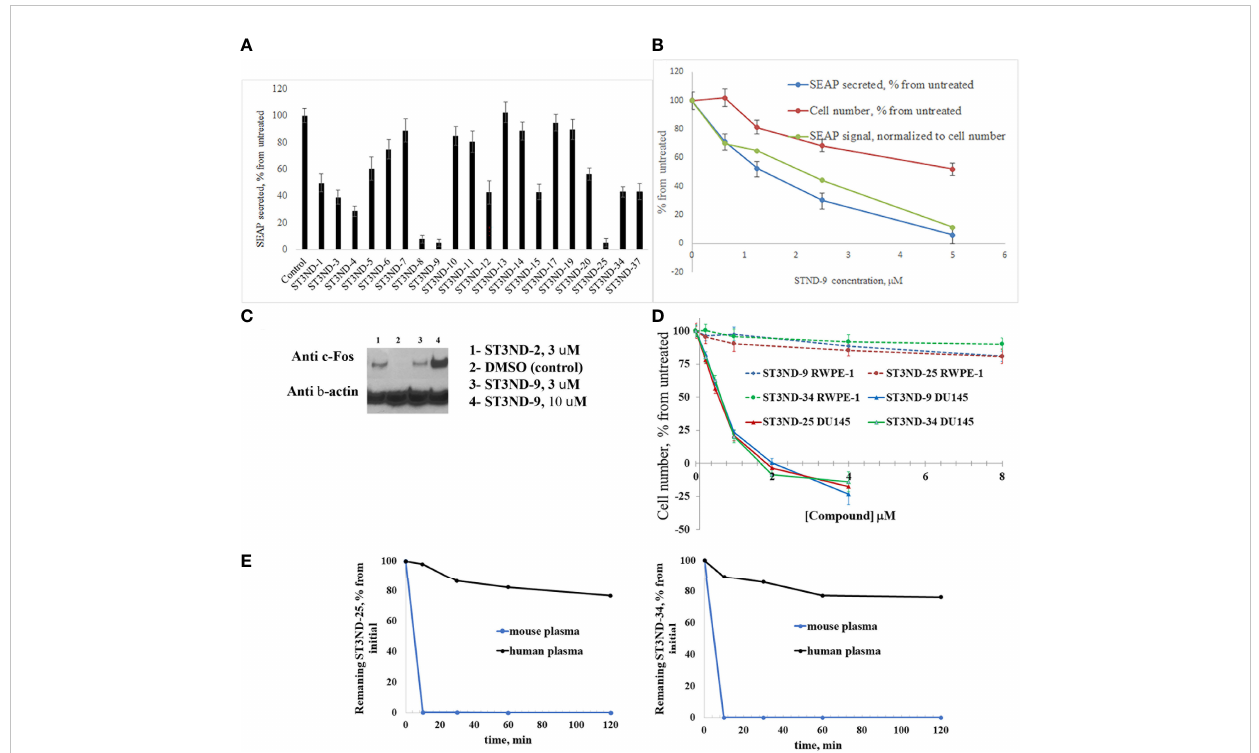
FIGURE 2 Compounds interfere with STAT3 N-domain signaling. (A) , STAT3 ND binders inhibit STAT3 signaling in HEK-BLUE IL-10 reporter cells. Cells (~70,000 cells/ mL) were incubated with IL-10 (0.1 ng/ml) without or with 500 m M of compound by measuring secreted embryonic alkaline phosphatase (SEAP) levels induced by 24 hours incubation). (B) . Inhibition of IL-10 induced STAT3 signaling in HEK-BLUE IL-10 reporter cells was concentration-dependent. As expected, compounds exhibited cell toxicity (blue line). However, inhibition of STAT3 activity was more signi fi cant and did not appear to be toxicity mediated. (C) , Compounds induce expression of STAT3 ND inhibition marker c-Fos. DU145 cells were treated with compounds for 3 hours (with DMSO treatment as a negative control), and nuclear fraction was isolated and used for Western blot analysis as described(12). Anti-c-Fos antibody was used at 1:1000 dilution. The blot was stripped and re-probed with b -Actin antibody at 1:1000 to demonstrate equal loading of the wells. (D) . Compounds are selectively toxic to prostate tumor cells (DU145) and show very little toxicity to normal prostate epithelial cells (RWPE-1). (E) , Lead compounds ST3ND-25 and ST3ND-34 are stable in human plasma, but undergo rapid metabolism in mouse